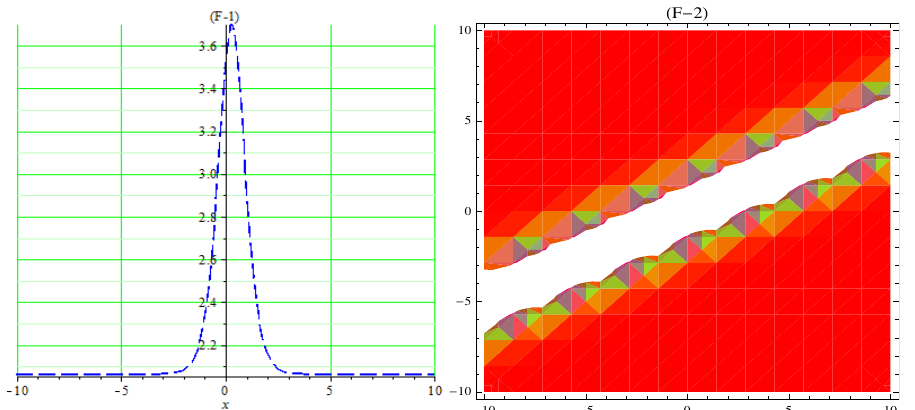
Figure 6. ( F ) 3D graph of bright soliton of (49) using l = 1.3, m = 0.4, µ = 0.5, A = 2.8, ζ = 0.7, V = 0.4, λ = 0.6. ( F-1 ) 2D plot and ( F-2 ) contour plot of (49).